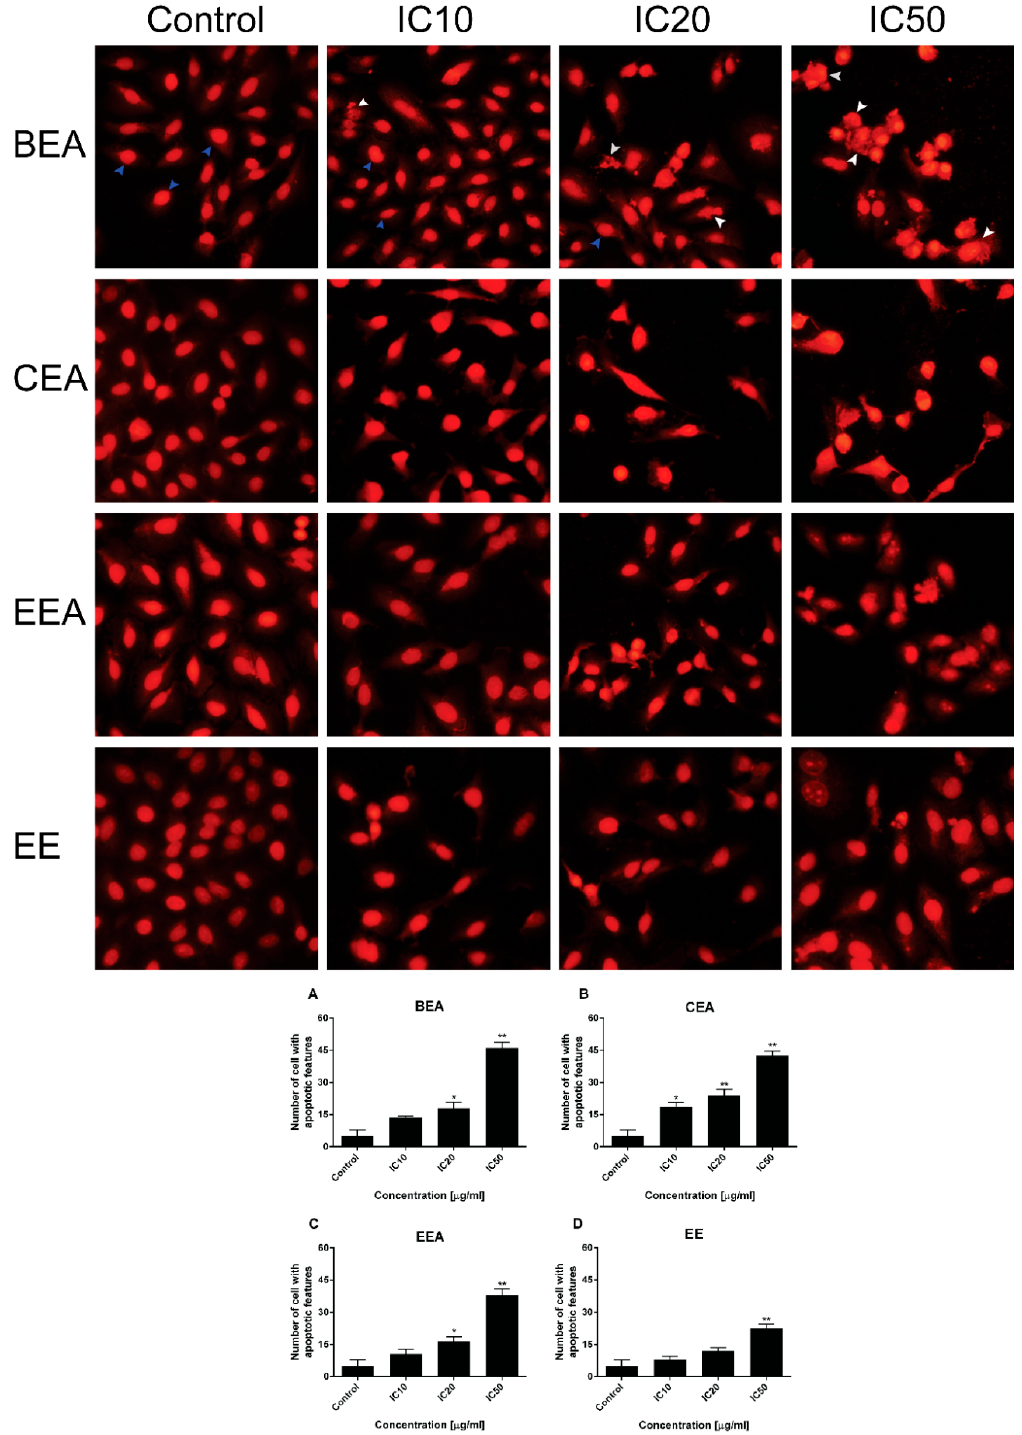
Figure 5. The e ff ective extracts induced an A549 cell apoptotic feature. Morphology of the A549 cells was determined and quantified after treatment with ( A ) BEA, ( B ) CEA, ( C ) EEA, and ( D ) EE for 24 h. Apoptotic bodies and condensed nuclei appeared after staining with propidium iodide. White arrows represent apoptotic cells, whereas blue arrows represent non-apoptotic cells. The number of cells with an apoptotic feature was shown in the bar graphs for 200 total cells counting. Significant results were compared with the control (without treatment) and are shown by * p < 0.05, ** p < 0.01.